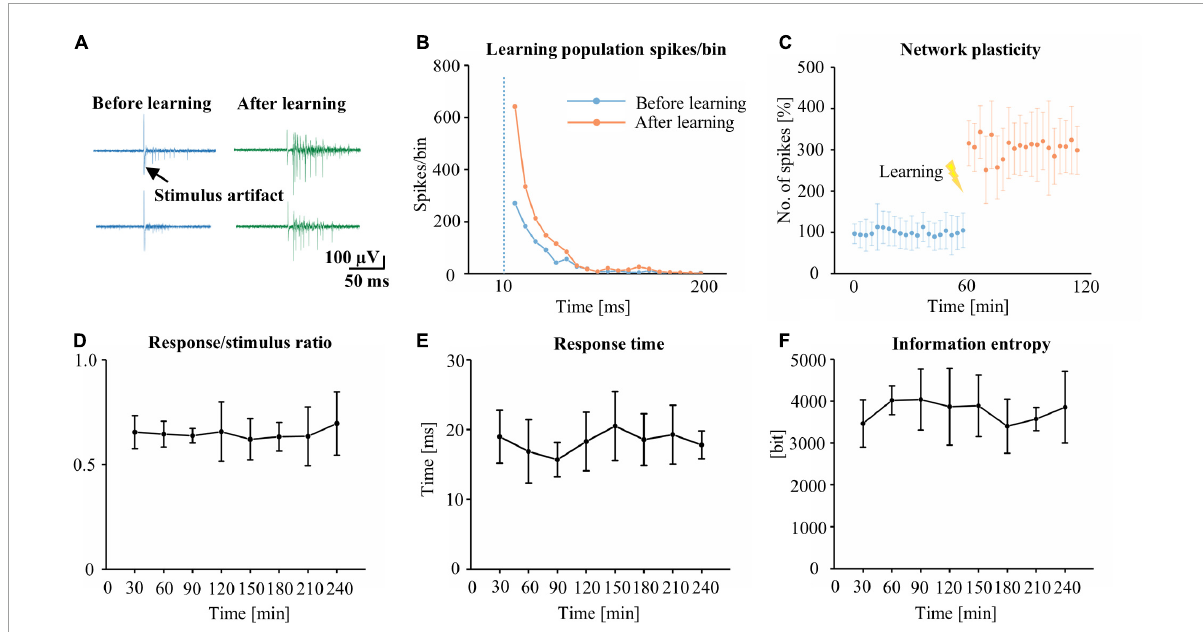
FIGURE3 The identification of learning and network plasticity. (A) The original trace represents the typical stimulus-evoked responses before and after training. (B) A comparison of typical stimulus-evoked responses of learning populations within 200 ms of the stimulus, before and after learning ( n = 349 learning populations, bin = 10 ms). (C) Time course of the number of spikes in the stimulus-evoked responses of learning populations before and after learning (time: 120 min, 100% represents the average before training for 60 min). The R/S ratio (D) , RT (E) and information entropy (F) of learning populations during the test phase ( n = 5 cultures. R/S: response/stimulus, RT: response time).